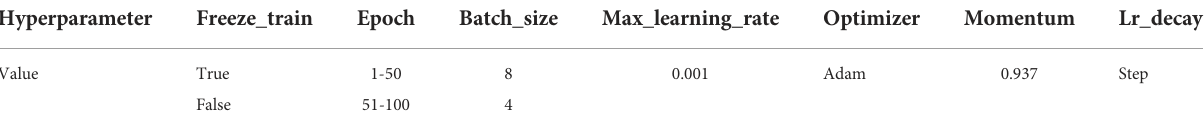
TABLE 1 Experiment-related hyperparameter